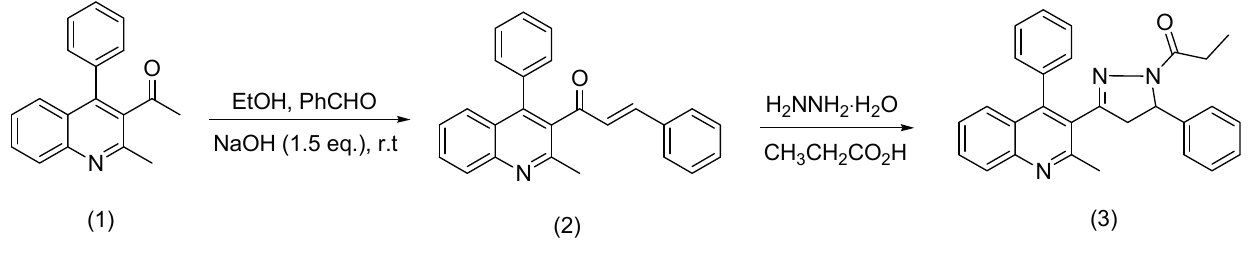
Scheme 1. The synthesis of